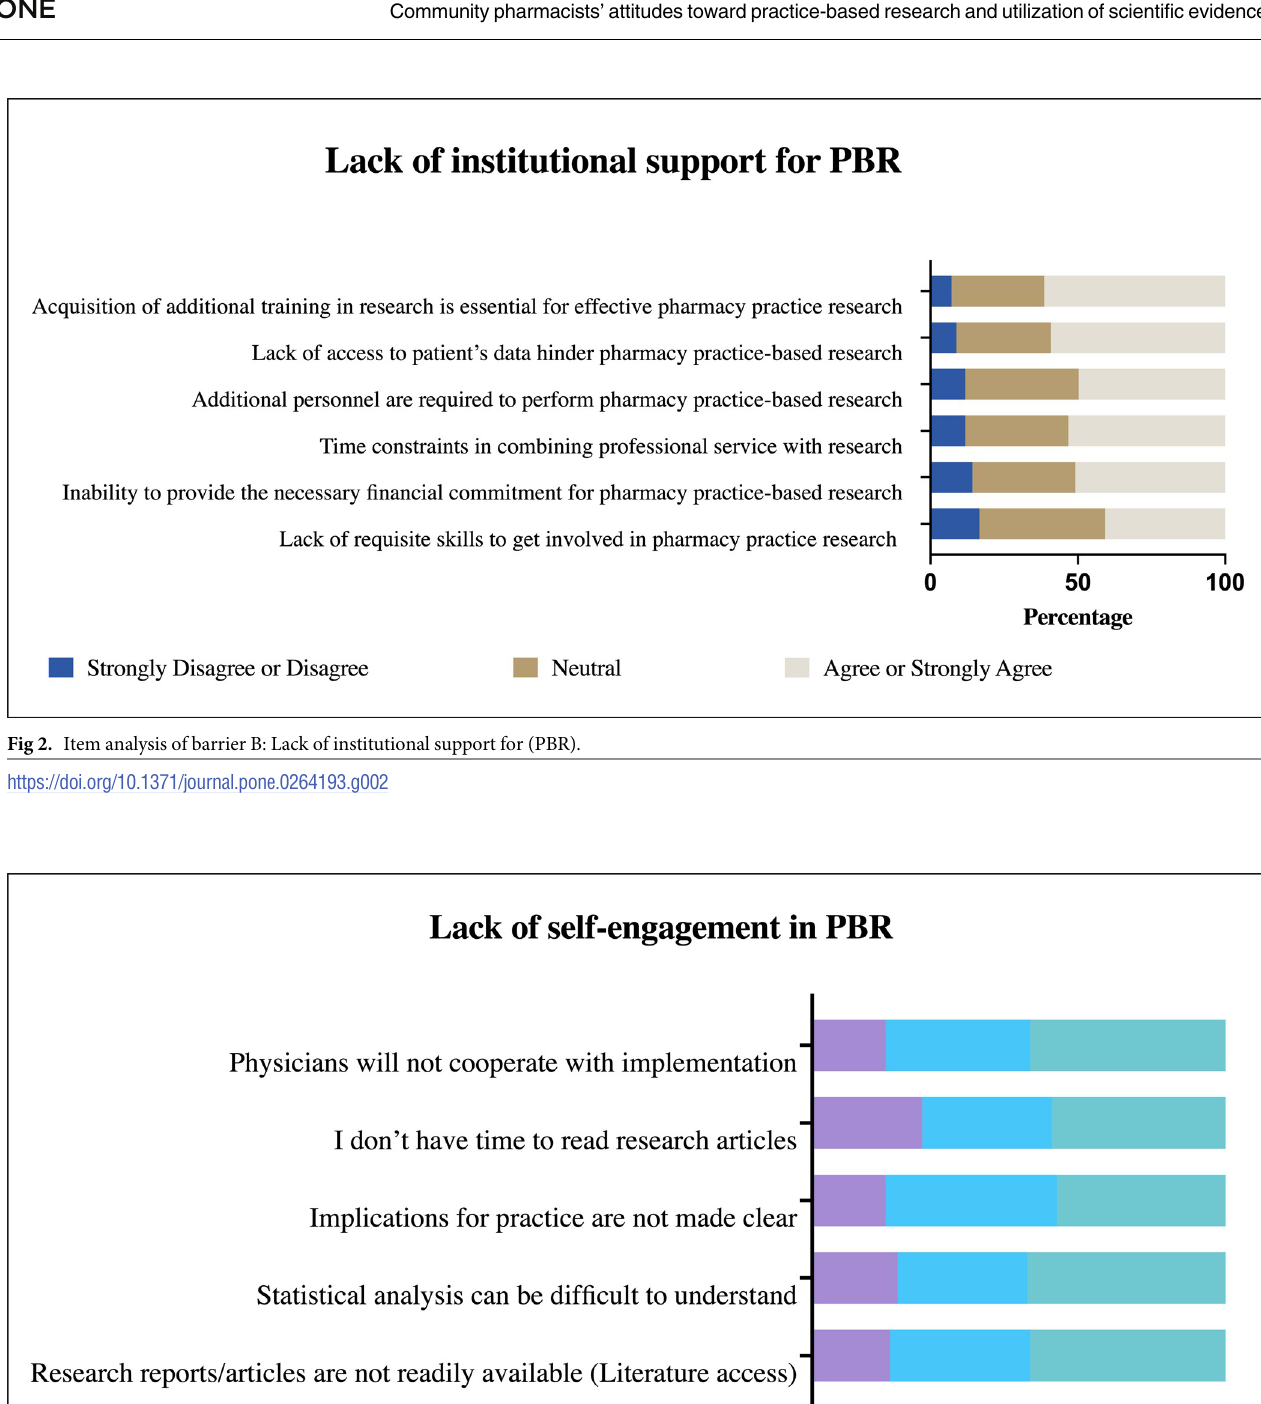
PLOS ONE | https://doi.org/10.1371/journal.pone.0264193 March 15,